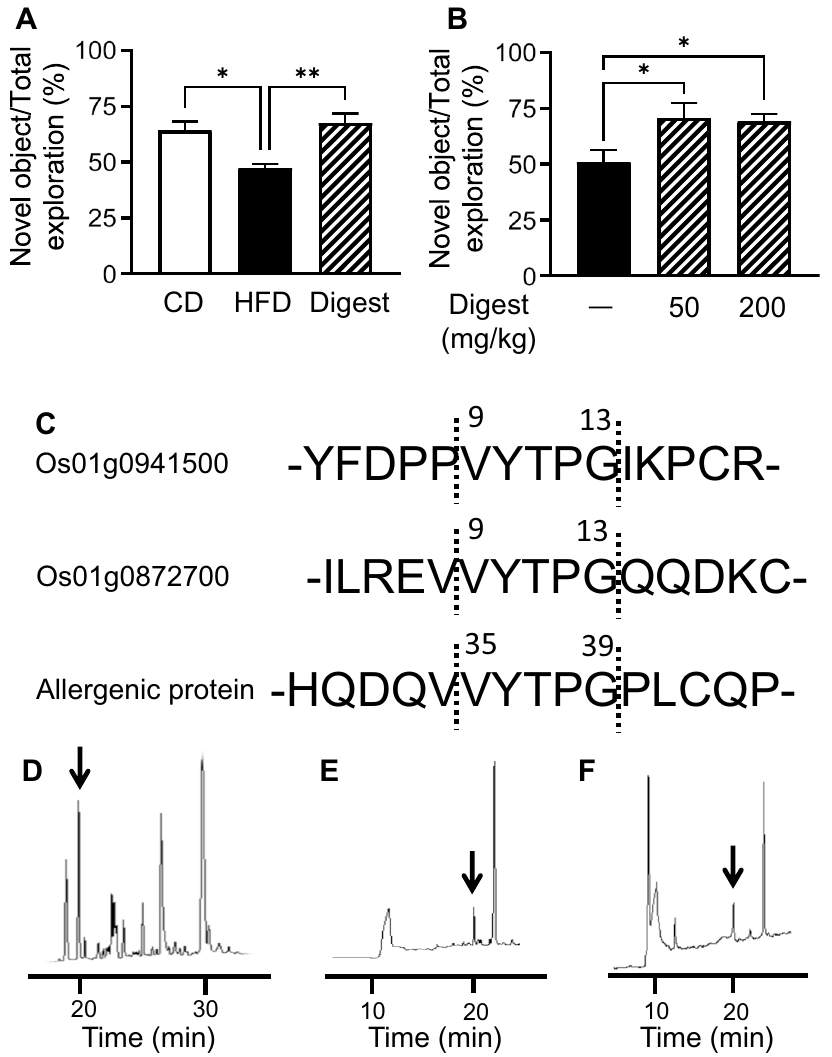
Figure 3. Effect of rice bran digest on cognitive decline and release of VYTPG, named as rice-memolin, from three model peptides corresponding to partial sequences of the original proteins. ( A ) Mice were fed CD, HFD, or 0.04% digest-mixed HFD for a week. Thereafter, the novel ORT was performed. ( B ) Mice were fed HFD for a week and the digest was administered orally at a dose of 50 and 200 mg/kg (once a day for 3 days). Thereafter, the novel ORT was performed. All values are means ± SEM ( A , n = 5–8; B , n = 12–13). * P < 0.05, ** P < 0.01 vs. HFD group. ( C ) Each model peptide, corresponding to partial sequence of rice protein candidate containing VYTPG sequence, was synthesized. These HPLC chromatograms showed that VYTPG was released by thermolysin digestion from the model peptides corresponding to the partial sequence of ( D ) Os01g0941500, ( E ) Os01g0872700, and ( F ) allergenic